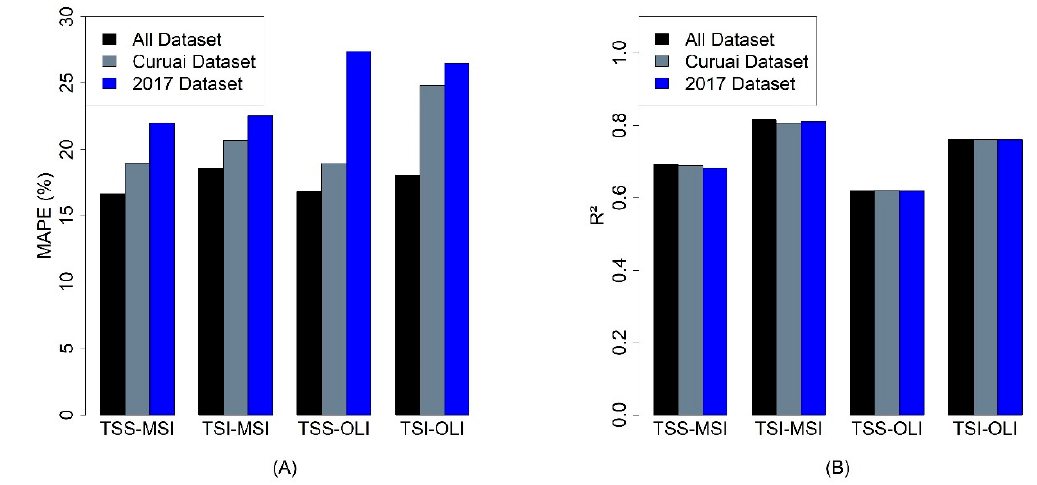
Figure 11. The barplots with MAPE ( A ) and R 2 ( B ) values for TSS and TSI estimates using All, Lake / Curuai, and Campaign / 17 Dataset Monte Carlo-calibrated models applied to both sensors imagery using equations from Table 6.